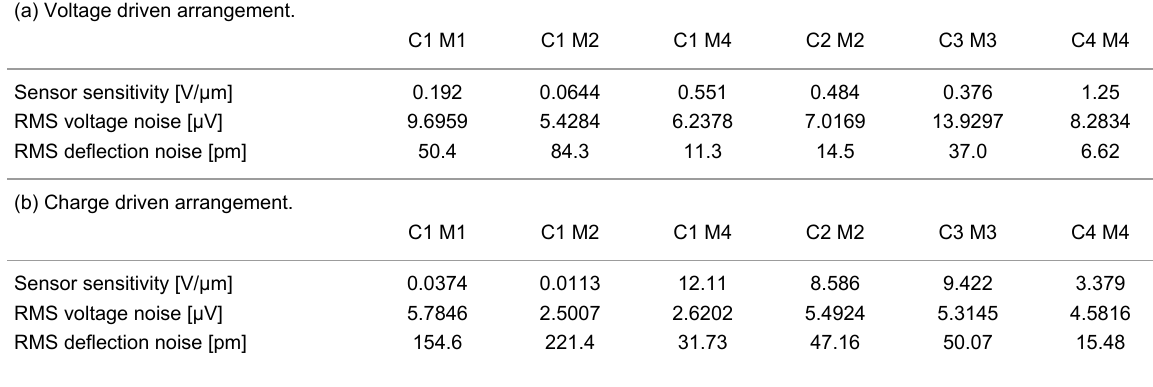
Table 4: Sensor sensitivities and noise performance of non-optimized and optimized higher order modes. (a) Voltage driven